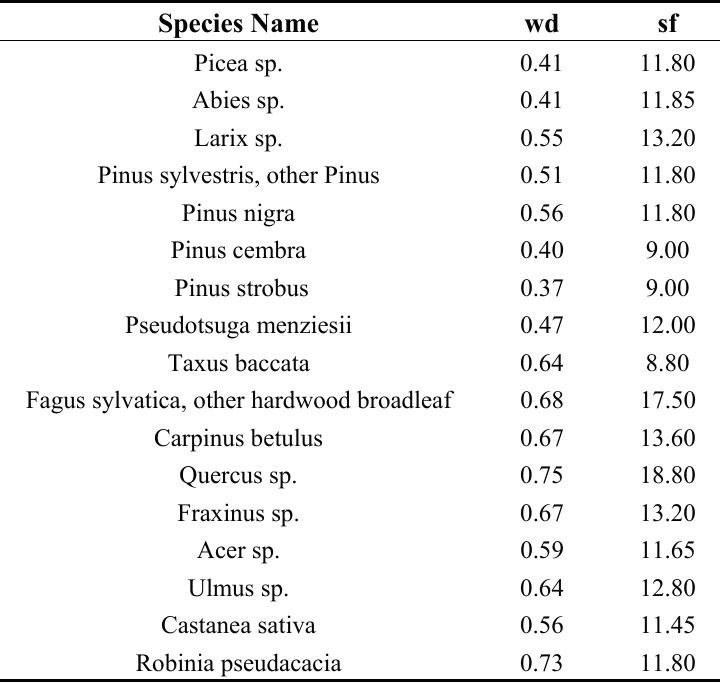
Table A3. Conversion factors for stem biomass